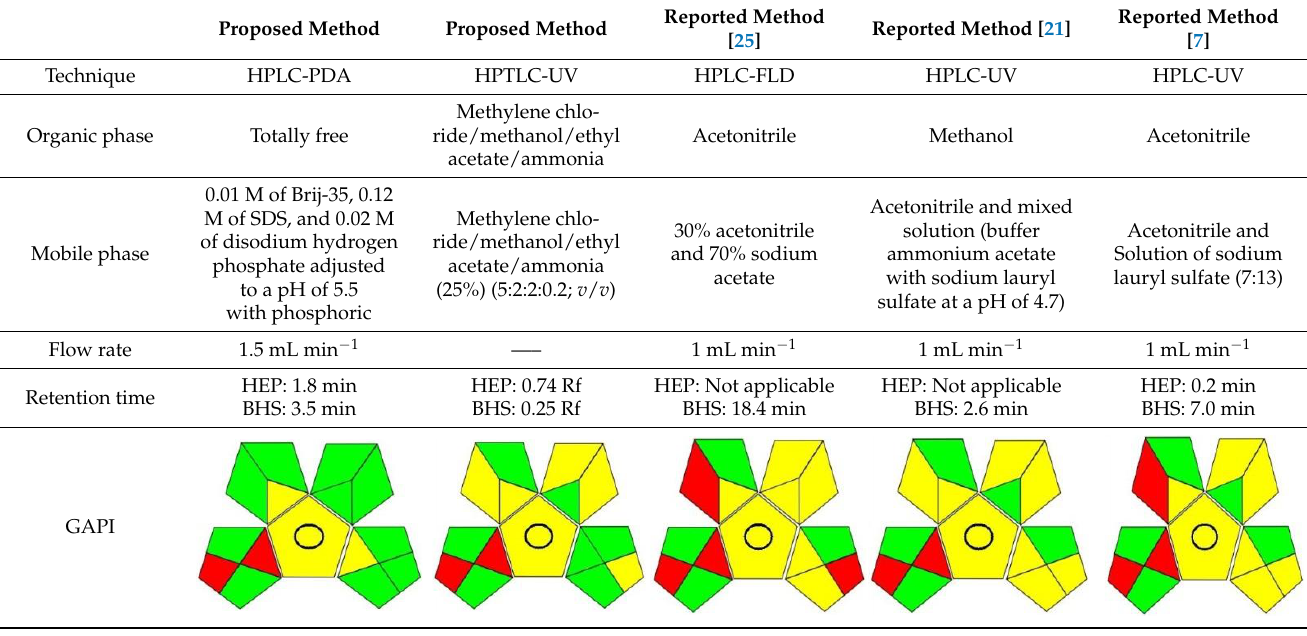
Table 5. Comparison of the proposed analytical method with previously reported methodologies.